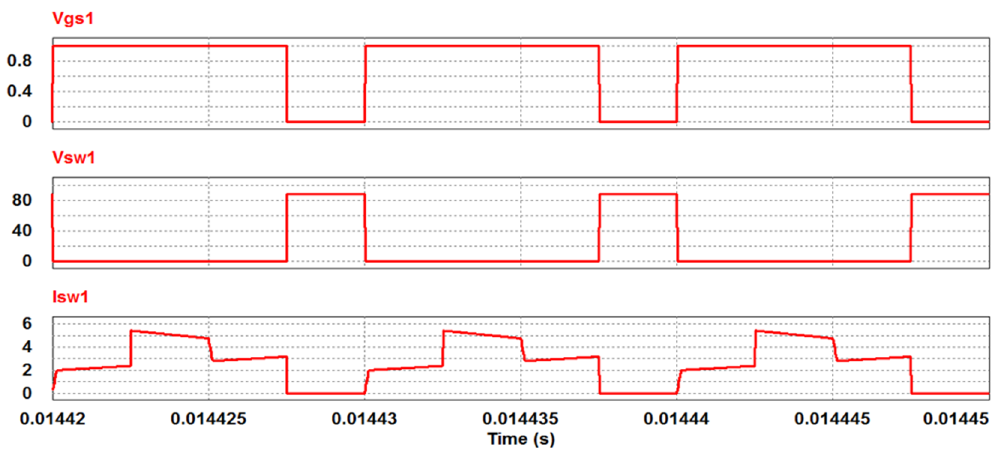
Figure 13. Gate pulse, drain-source voltage and switching current.